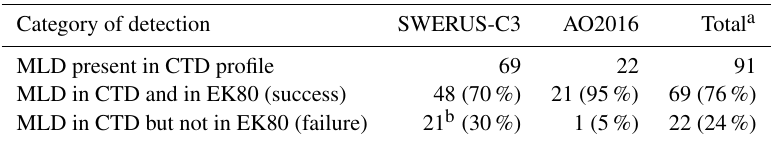
Figure 2. Continuous tracking of MLD in the central Arctic Ocean over a 117km cruise track. Data were acquired 12–13 September 2016 at 14.5 ◦ E, 86.1 ◦ N. (a) EK80 echogram (2ms pulse length) with magnified insets (dashed boxes) showing the MLD while drifting (left) and while steaming (right). (b) CTD profiles showing temperature (magenta) and salinity (cyan). (c) Reflection coefficients derived from CTD data (magenta) and from scatter strength; black cross represents the observed scatter strength of − 65dB at this depth extracted from the left inset in (a) . (d) Heave (black), speed over ground (blue), and time periods corresponding to ice breaking (red), steaming (green), and drifting (yellow). Vertical magenta lines in (a) show the position of the CTD. The red cross in (a) (left inset) marks the depth of the reflection coefficient spike in (c) . Note that the ability to detect MLD acoustically is severely reduced while breaking ice. Table 1. Success and failure rates of acoustic detection of MLD when present in CTD